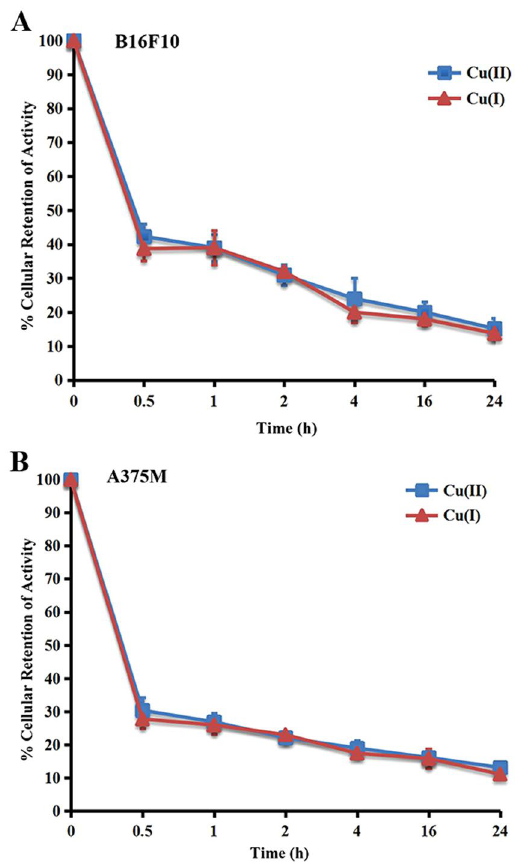
Figure 2. Cell efflux assay from B16F10 and A375M cells after 2 h incubation with 64 Cu(II) and 64 Cu(I) at 0.5, 1, 2, 4, 16 and 24 h,